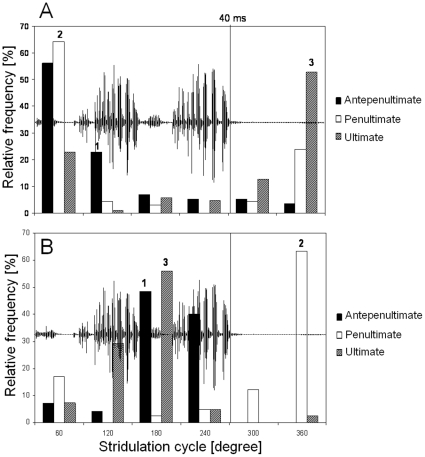
Phase-dependent song pausing of T. viridissima males elicited by repetitive ultrasound pulses.Histograms showing the phase of ultrasound pulses preceding song pausing in the stridulation cycle of T. viridissima. (A) 50 ms pulse repetition period: Two of three consecutive ultrasound pulses (labeled 2, 3) preceding song pausing were coincident with phases of relative silence. (B) The majority of ultrasound pulses presented with a pulse repetition period of 25 ms coincided with pauses between double-syllables (labeled 2) as well as with soft hemi-syllables separating syllable pairs (labeled 1,3) (B). Vertical lines in A and B indicate the average double syllable duration (40 ms). Data shown in histograms were obtained from 131 stimulus-associated song pauses (7 males tested at an ambient temperature of 28°C).